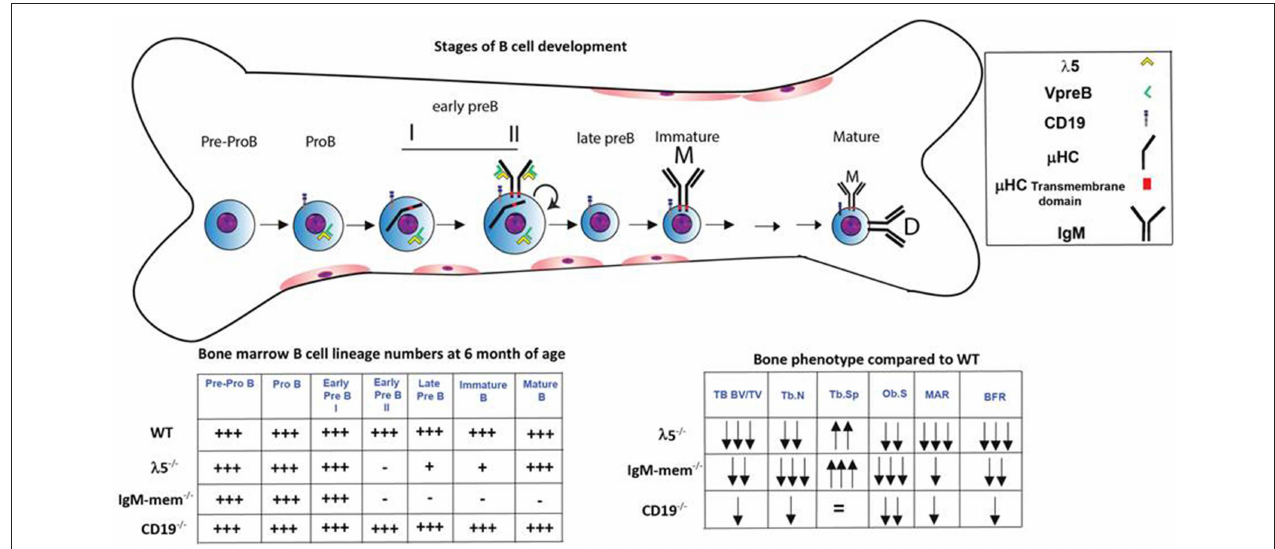
FIGURE 4 | Markers and stages of B cell development that are associated with impairment in postnatal bone mass. B cell development begins in the bone marrow and then continues in the periphery. The stages at which development is affected in the λ 5 − / − , IgM-mem − / − , and CD19 − / − mice and the relative number of bone marrow B lineage cells at 6 months of age at each stage of development are illustrated (18–20, 24, 25, 28). The two charts summarize the changes in bone marrow B lineage cell numbers and adult bone mass for each genotype.